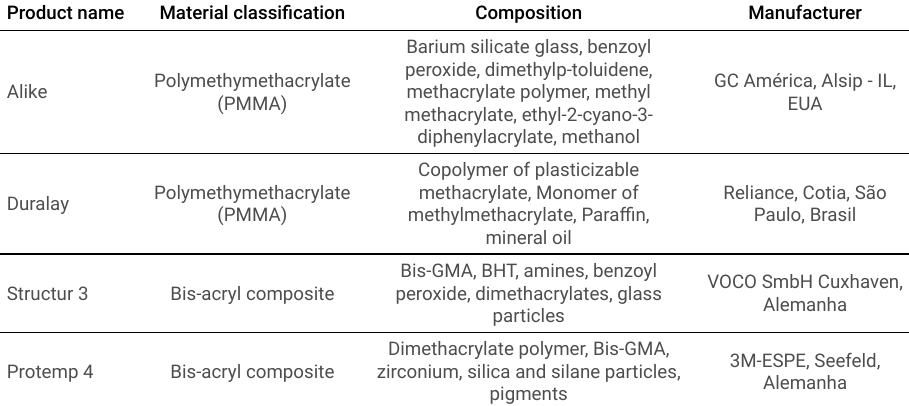
Table 2. Provisional prosthetic materials used in the present